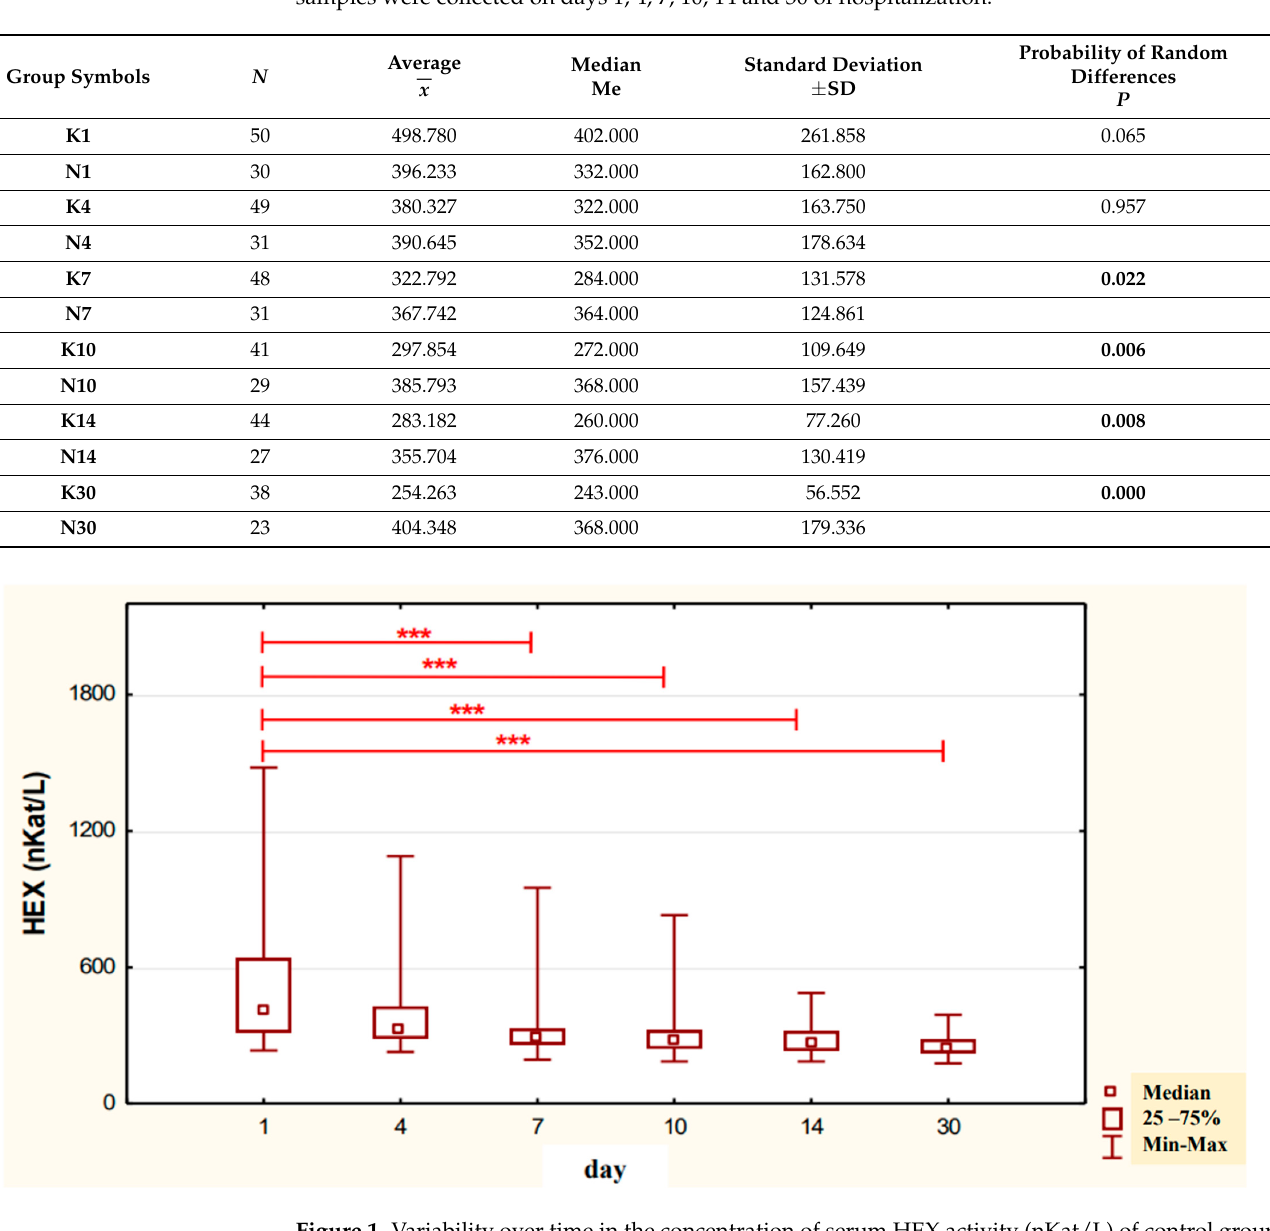
Figure 2. Variability over time in the concentration of serum HEX activity (nKat/L) of al- cohol-dependent patients treated with neoglandin (N).